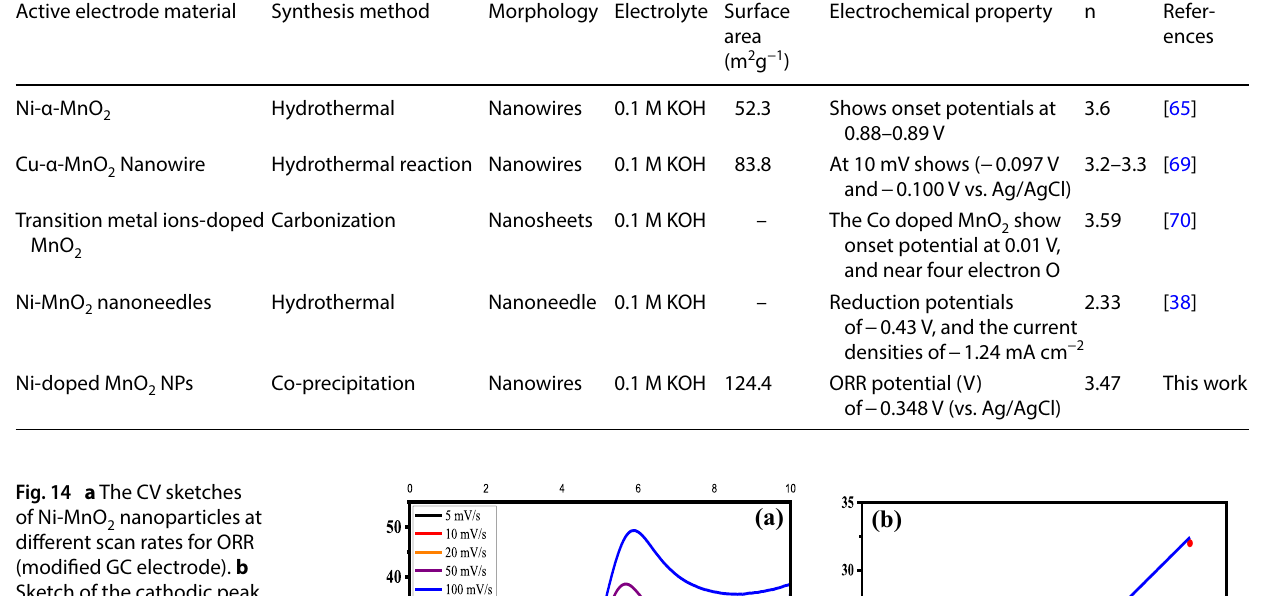
Fig. 14 a The CV sketches of Ni-MnO nanoparticles at 2 different scan rates for ORR (modified GC electrode). b Sketch of the cathodic peak current with respect to v 1/2 . c Sketch of the cathodic peak current with respect to v . d